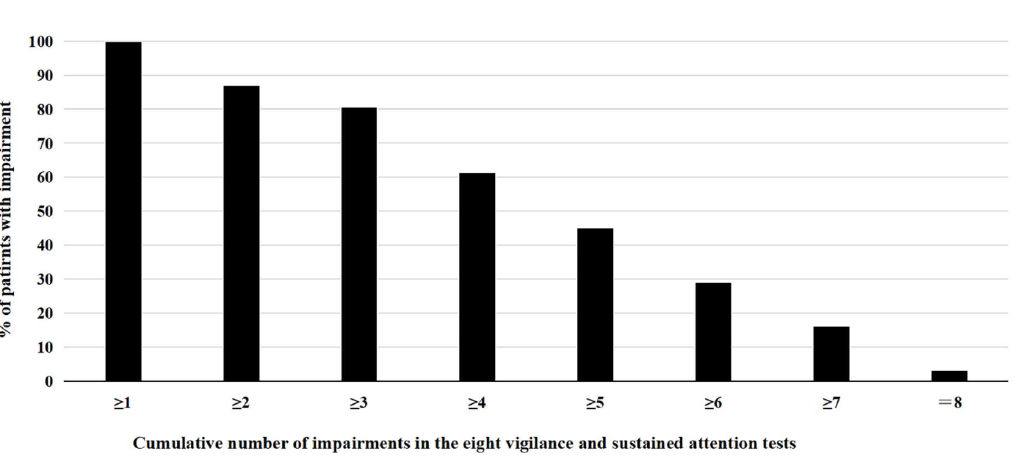
Figure 4. Cumulative percentage of patients with ADHD showing impairment in vigilance and sustained attention tests. Note: A test is defined as impaired if at least one test variable shows impairment. A test variable is defined as impaired when T -score ≤